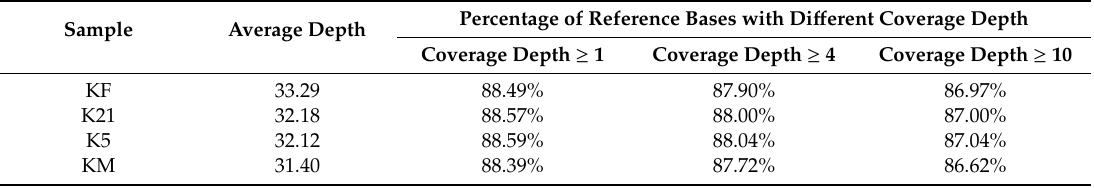
Table 3. Summary of reference bases with di ff erent coverage depth.